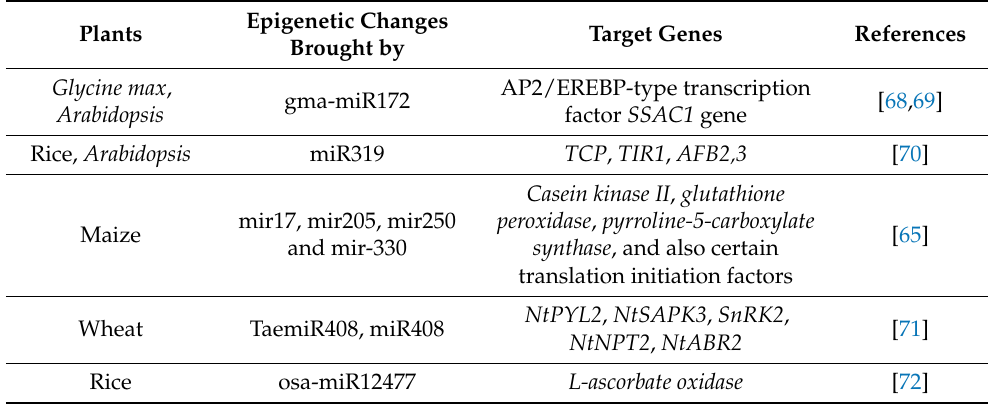
Table 3. miRNAs arise from primary miRNA transcripts. DNA polymerase II transcribes them from miRNA genes [61]. Within their stretch, these pri-miRNAs contain a hairpin loop-like precursor RNAs called pre-miRNA. The pre-miRNA hairpin precursor contains 20 - 22 nucleotide long miRNA–miRNA* duplex structure. The miRNA* strand is degraded by Dicer-like 1 (DCL1) protein while miRNA remains intact. Methylation occurs at the 3 (cid:48) end of the duplex by enzyme HUA ENHANCER1 (HEN1) and exportin protein HATSY transfers pre-miRNAs from the nucleus to the cytoplasm. This duplex upon transfer gets unwound by the helicases, and then miRNA shuttles into the RNA-induced silencing complex (RISC) and guides RISC to bind to related target transcripts based on comple- mentarities of the sequences [62]. Several miRNA species have been found to be operative under environmental stress conditions. In plants, the level of miRNAs transcripts under stress conditions, cannot be consistently correlated with adaptive machinery operative under stress [63]. Salinity-inducible miRNAs have been identified in numerous plants. [64], identified 22 new miRNAs in Raphanus sativus under salt stress. These miRNAs were related to growth modulation and ion homeostasis categories. In maize under salinity stress, mir17 , mir205 , and mir250 genes were downregulated in leaves. mir330 gene showed downregulation in roots. These miRNAs target genes such as casein kinase II, glutathione peroxidase, pyrroline-5-carboxylate synthase, and translation initiation factors ( IF - 1 ) along with other ones which are related to better survival strategies [65]. In Saccharum species, ex- pression of miRNAs relies on plant genre and also on the type of stress prevailing. miR156 , miR159 , miR166 , miR167 , miR168 , miR169 , miR396 , miR397 and miR398 were found to be upregulated [66,67]. Table 3. miRNAs mediated epigenetic changes under salinity stress. A summary of recently reported miRNAs and their targeted genes are enlisted here. Epigenetic Changes Plants Target Brought by